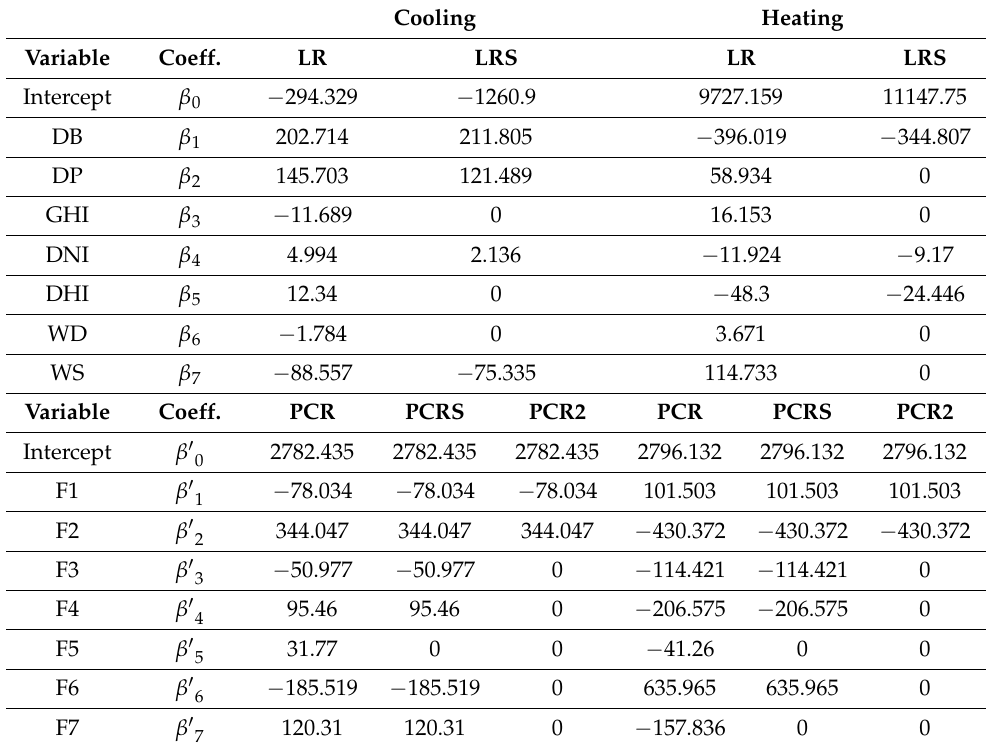
Table 1. Details of the regression coefficient values for heating and cooling energy use and following different regression